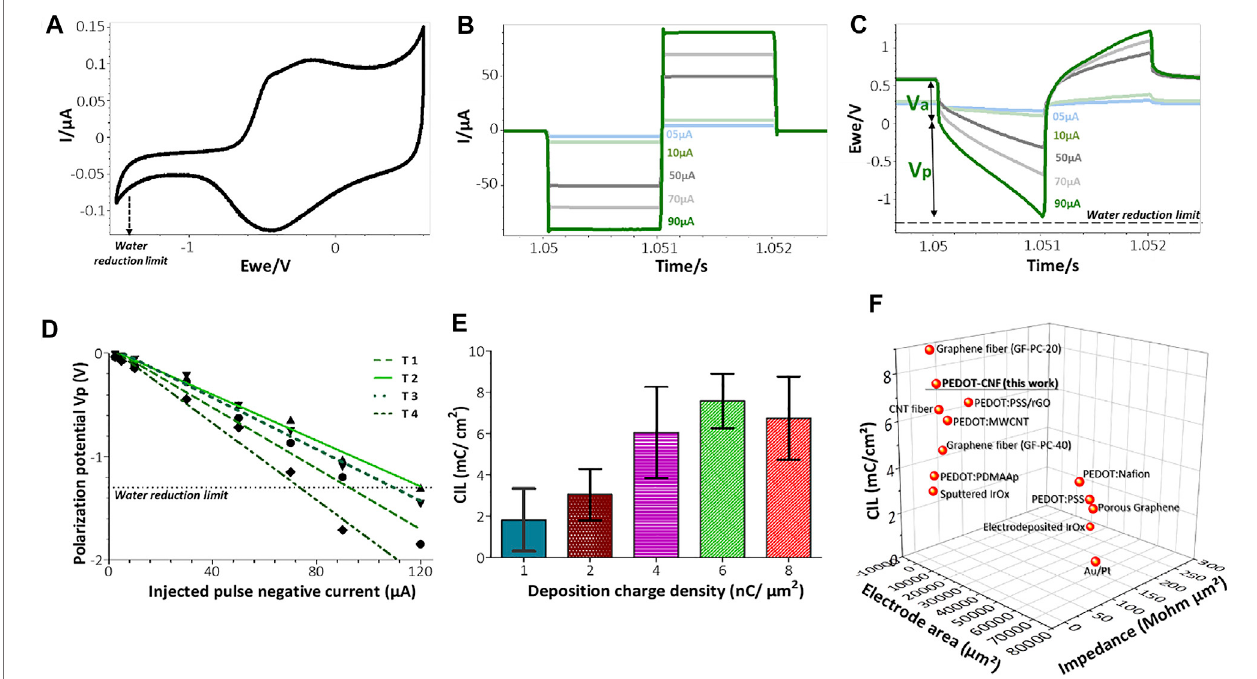
FIGURE 5 | In vitro biphasic stimulation assessment: (A) Determination of the water reduction potential by CV of PEDOT-CNF composite in aCSF at 200 mV/s V Ag/AgCl. Biphasic charge-balanced current pulses (B) and voltage responses (C) at different charge injections ranging from 5 to 90 µA; (D) Polarization potentials (Vp) measured under different current pulse amplitudes. The deposition condition of 6 nC/µm 2 was considered here and the data corresponding to 4 trials are represented; (E) Evolution of the charge injection limit (CIL) values with respect to the deposition charge density. (F) Comparison of the Impedance, CIL performances and geometric surface area of PEDOT-CNF composite deposited on the fl exible gold electrode surface with other fl exible neural electrode arrays. The corresponding values and references are reported in Supplementary Table S1 (For interpretation of the references to colors in this fi gure legend, the reader is referred to the web version of this